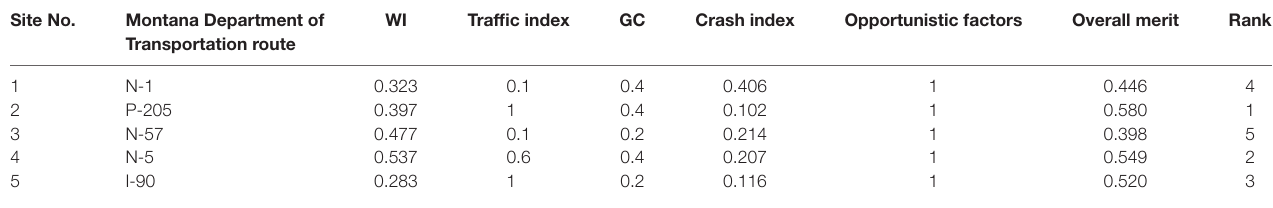
TaBle 8 | Application of proposed model on selected sites. site